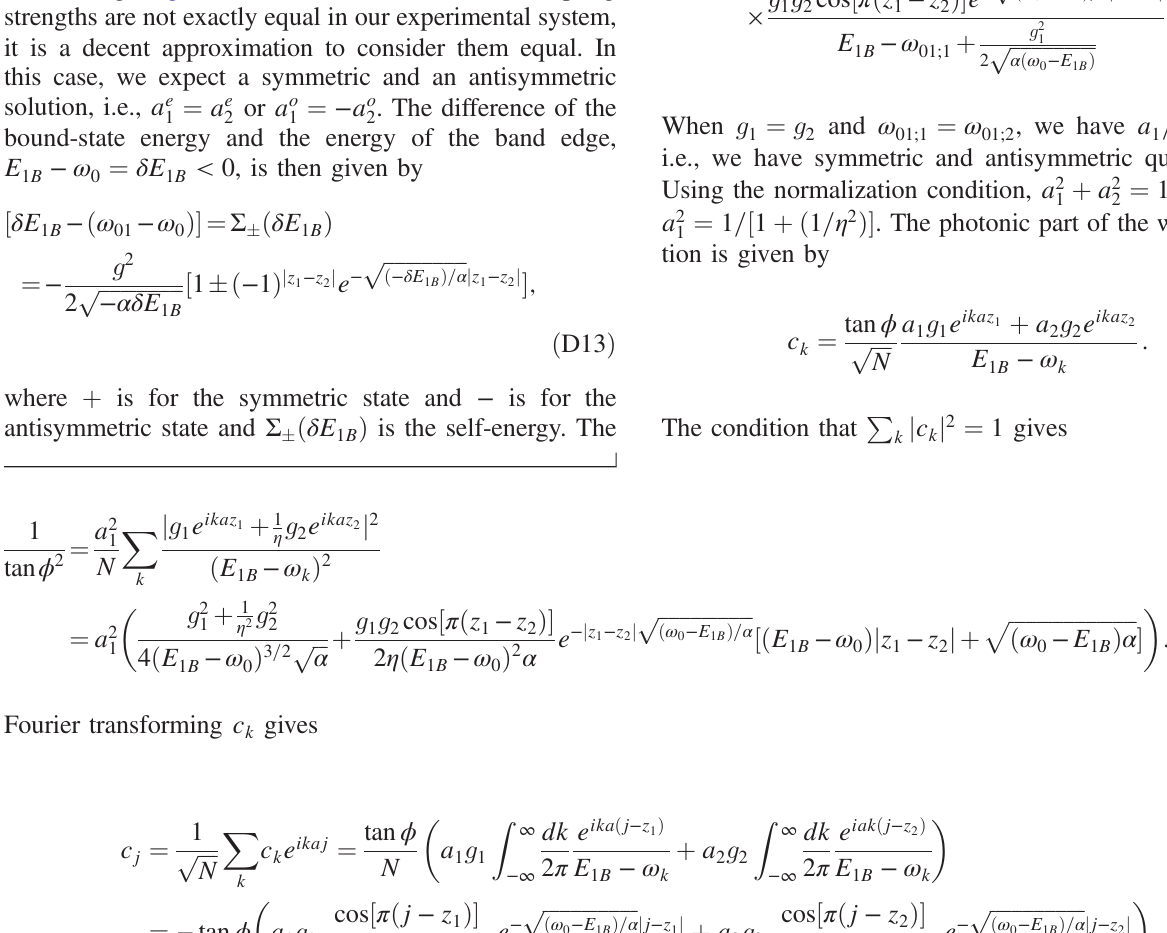
ffiffiffiffiffiffiffiffiffiffiffiffiffiffiffiffiffiffiffiffiffiffiffiffiffi − E α ð ω 0 1 B Þ